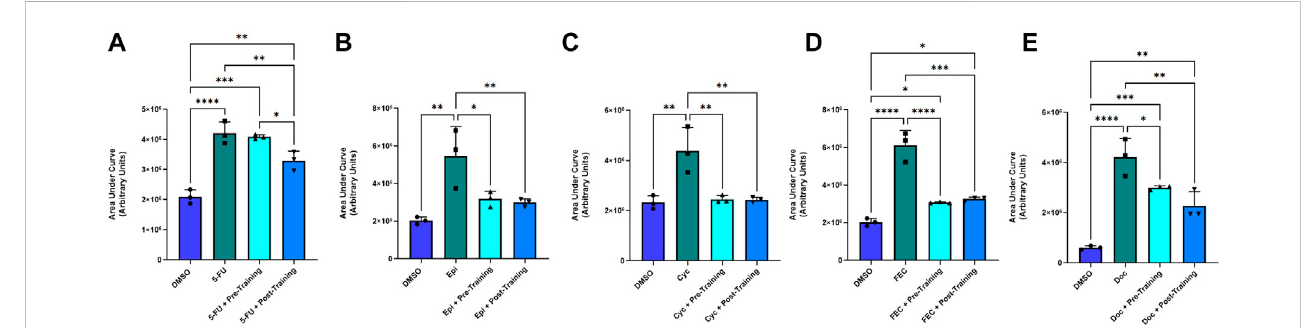
FIGURE 5 Area under the human coronary artery endothelial cells (HCAEC) gap closure curve with exposure to 1.5 µM 5- fl uorouracil (A) , 0.006 µM epirubicin (B) , 38 µM cyclophosphamide (C) , FEC combined (D) ; 5- fl uorouracil: 1.5 µM, epirubicin: 0.006 µM, cyclophosphamide: 38 µM, and 6 µM docetaxel (E) treatments with dimethyl sulfoxide (DMSO), drug without serum, pre-training serum with drug and post-training serum with drug. Data shown are mean ± SEM ( n = 3). * p < 0.05, ** p < 0.01, *** p < 0.001, **** p < 0.0001.